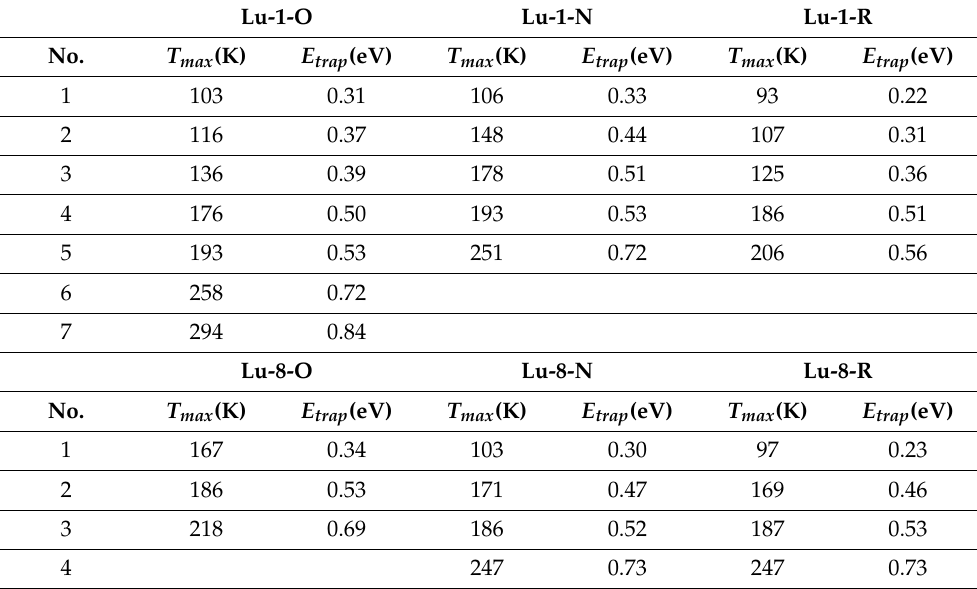
Table 2. The TSL fitted results of Lu 2 O 3 :1%Eu and Lu 2 O 3 :8%Eu single